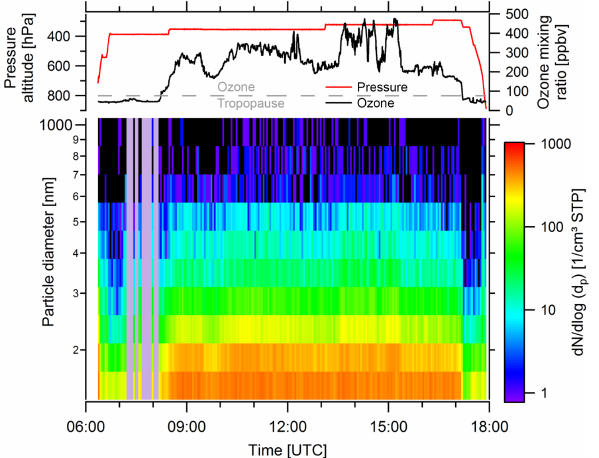
Figure 13. Accumulation mode particle number size distribution for the CARIBIC flight LH454 from Seoul, South Korea, to Frank- furt, Germany, on 4 December 2013. Cruise level data are ob- tained almost exclusively in the LMS, in air masses which are characteristic for air from 2 to 3km above the thermal tropopause (see www.knmi.nl/samenw/campaign_support/CARIBIC/041213a/ index.html, accessed 1 July 2015). The red line gives the aircraft pressure altitude, the black line the ozone mixing ratio, and the color code the particle number concentration in 10 particle size bins. Gray bars indicate periods of inside cloud